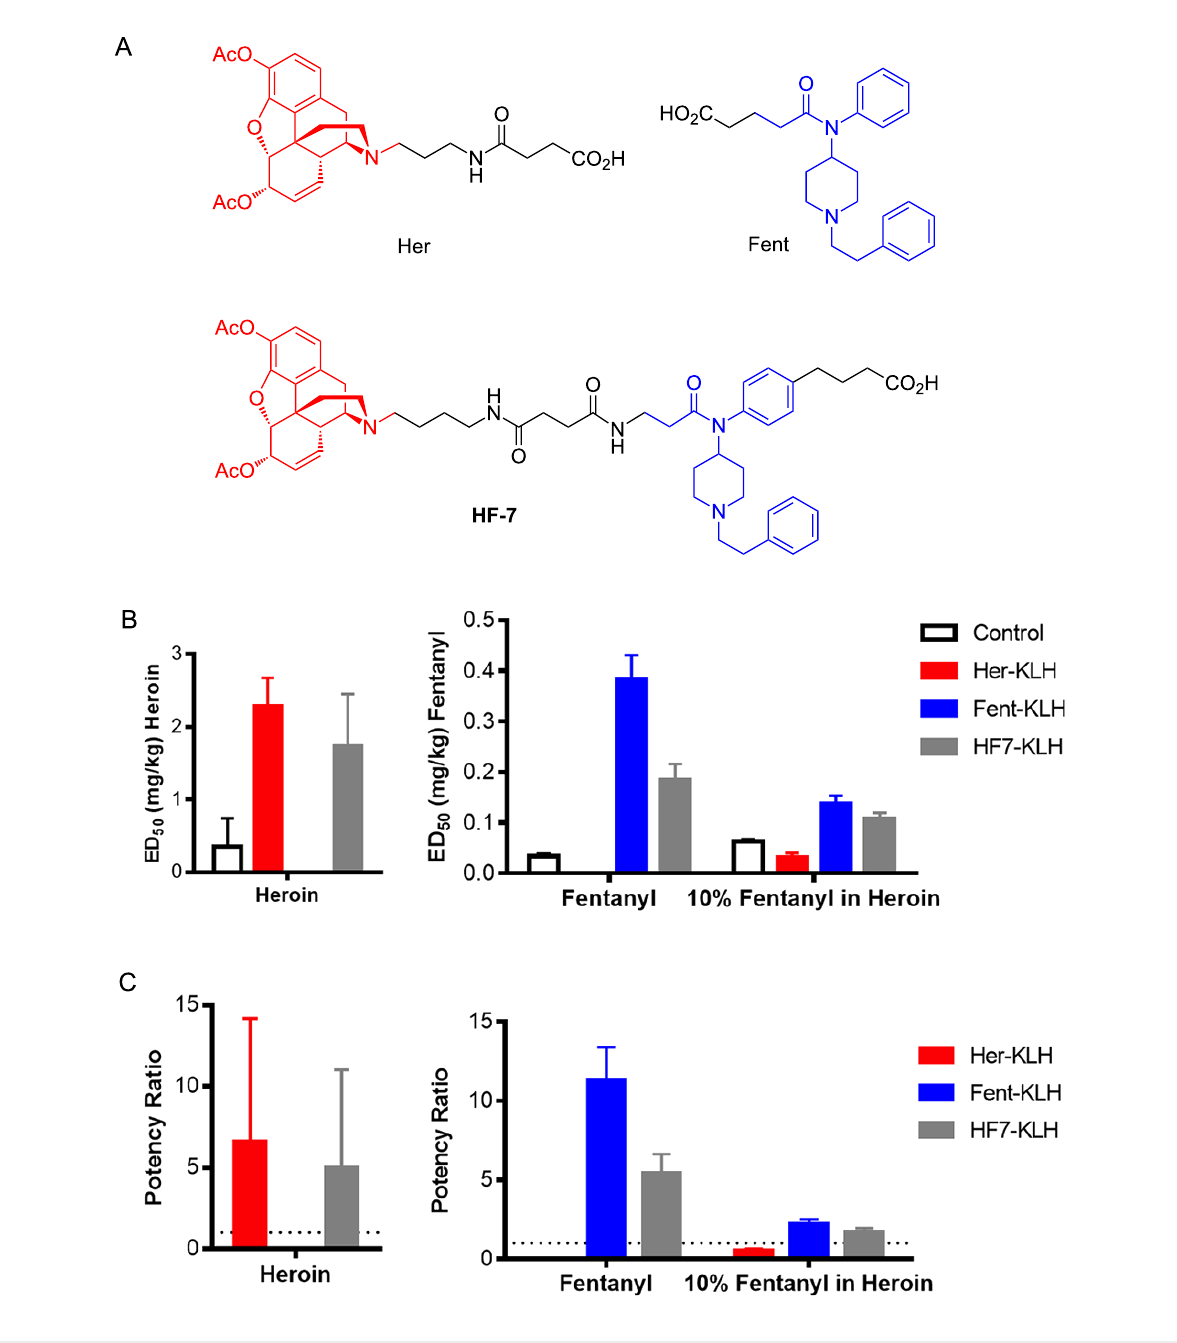
Figure 5: Summary of behavioral data for most promising chemically contiguous vaccine HF-7 , compared to singular hapten-vaccines and controls. A) Structures of haptens; B) ED 50 values for heroin and fentanyl; C) potency values. Bars represent means + SEM.